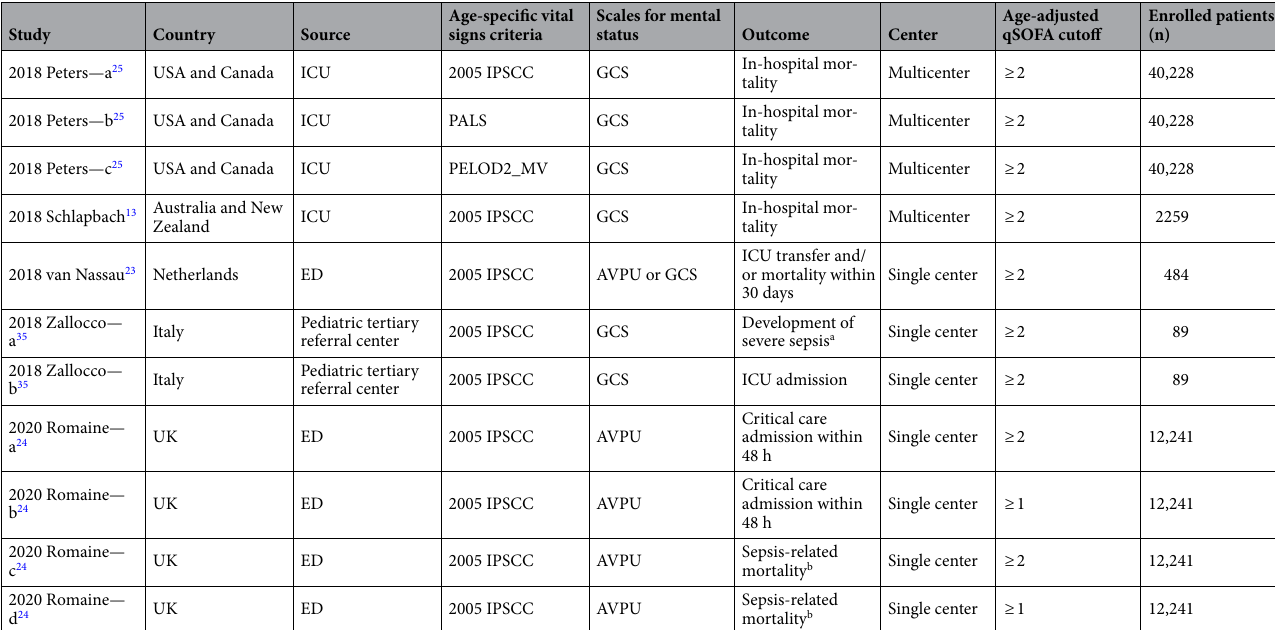
Table 1. Characteristics of the included studies. AVPU, Alert, Voice, Pain, Unresponsive scale; ED, emergency department; GCS, Glasgow Coma Scale; ICU, intensive care unit; IPSCC, International Pediatric Sepsis Consensus Conference; PALS, Pediatric Advanced Life Support; PELOD2_MV, Pediatric Logistic Organ Dysfunction 2 with the use of mechanical ventilation; qSOFA, quick Sequential Organ Failure Assessment score; UK, United Kingdom; USA, United States of America. a Defined by the 2005 International